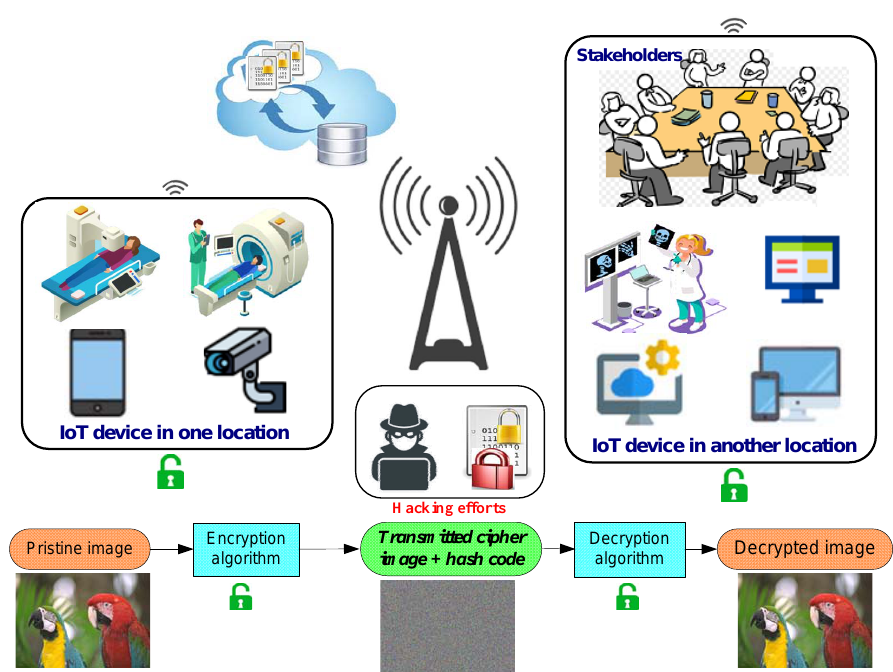
Figure 1. Proposed framework for the secure transmission of multimedia data in IoT